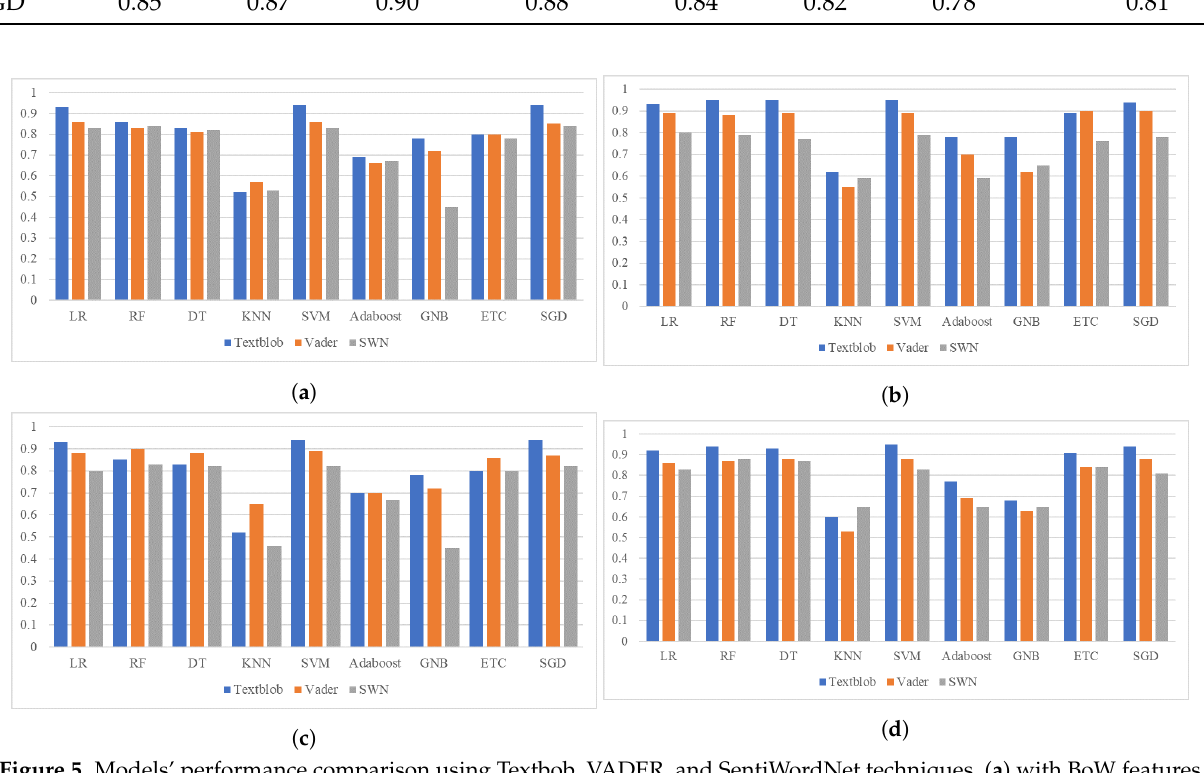
Figure 5. Models’ performance comparison using Textbob, VADER, and SentiWordNet techniques, ( a ) with BoW features on the original dataset; ( b ) with BoW features on the SMOTE balanced dataset; ( c ) with TF-IDF features on the original imbalanced dataset; and ( d ) with TF-IDF features on the SMOTE balanced